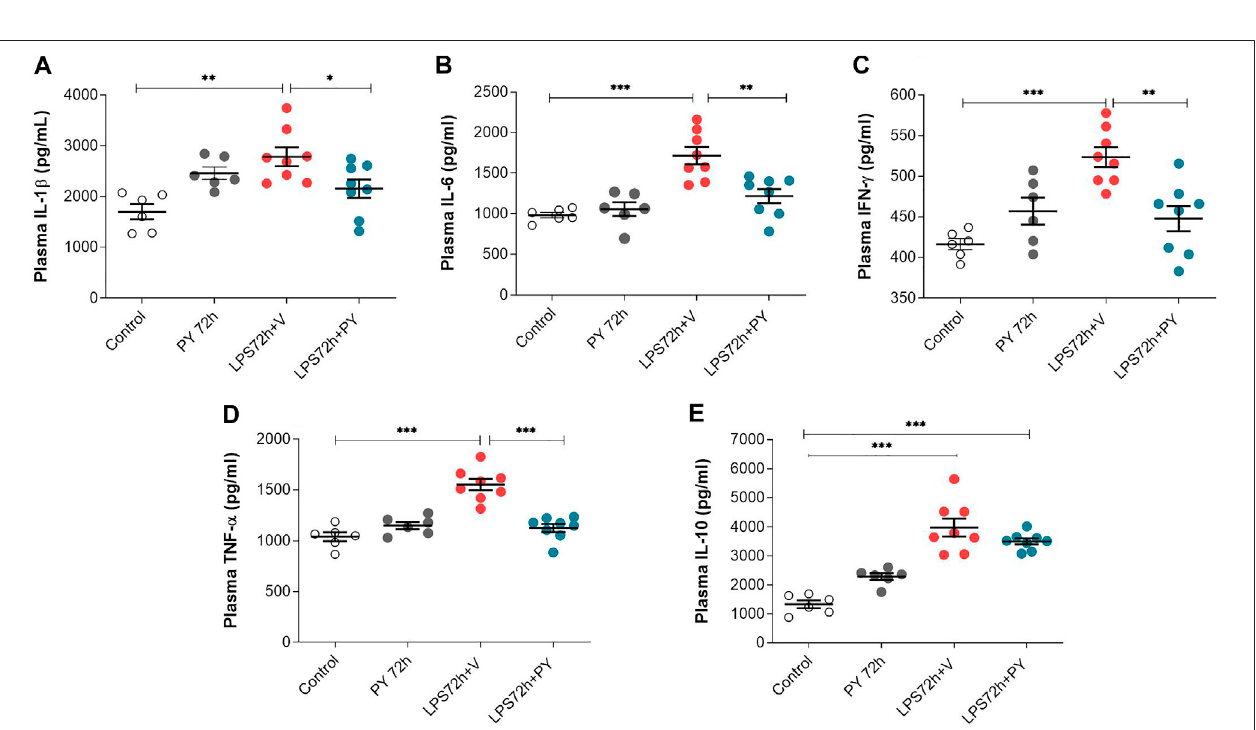
FIGURE7 | Pyridostigmine suppresses plasma cytokine levels in LPS exposed mice at 24 h. (A) IL-1 β , (B) IL-6, (C) IFN- γ , (D) TNF- α , (E) IL-10. *** p < 0.001, ** p < 0.01and * p < 0.05. Vehicle(V)group (Control),pyiridostigmine(PY), lipopolysaccharide(LPS). Valuesexpressed asmean ± SEM.One-wayANOVA followed byTukey ’ s test (See text for details).